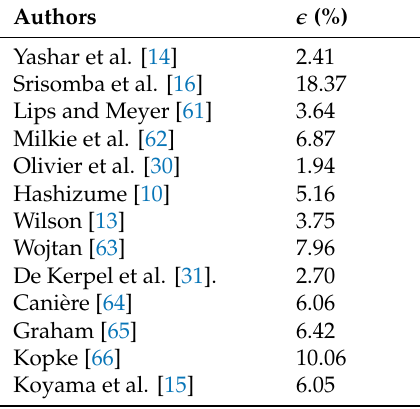
Table 11. Mean absolute error between the new correlation and each database for macrochannel